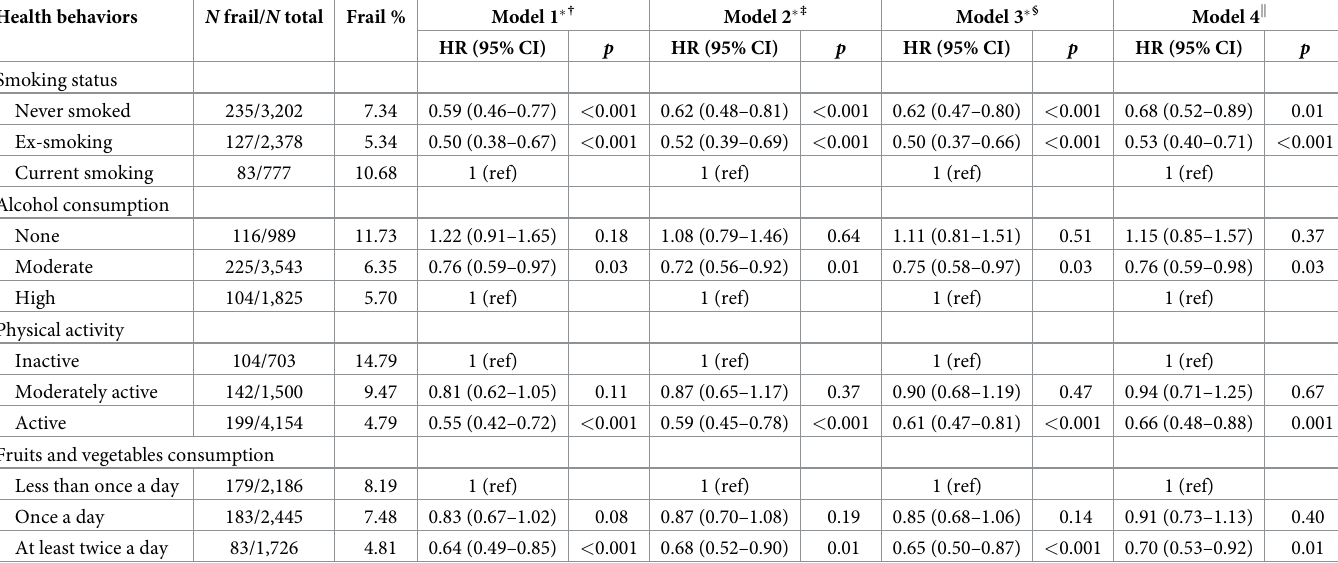
inactive, and to eat fruits and vegetables less frequently at age 50 (all p < 0.001). At the end of follow-up, each frailty component, apart from weight loss, was present in over 60% of the frail group (Table 1). The proportion of participants who were white, married/cohabiting, with higher socioeconomic background, and with fewer morbidities was higher among those with a greater number of healthy behaviors at age 50 (all p < 0.05; S3 Table). Because there was no evidence of an interaction of the number of healthy behaviors with sex ( p = 0.22), education ( p = 0.47), and occupational position ( p = 0.14), analyses were under- taken in the total population. The association between each health behavior at age 50, catego- rized in 3 groups, and subsequent risk of frailty is shown in Table 2. Unadjusted incidence rates per 1,000 person-years among never, ex-, and current smokers were 3.57, 2.60, and 5.41, respectively. In analyses adjusted for demographic factors, never (HR 0.59, 95% confidence Table 2. Association between health behaviors at age 50 and onset of frailty over a mean follow-up of 20 years. Health